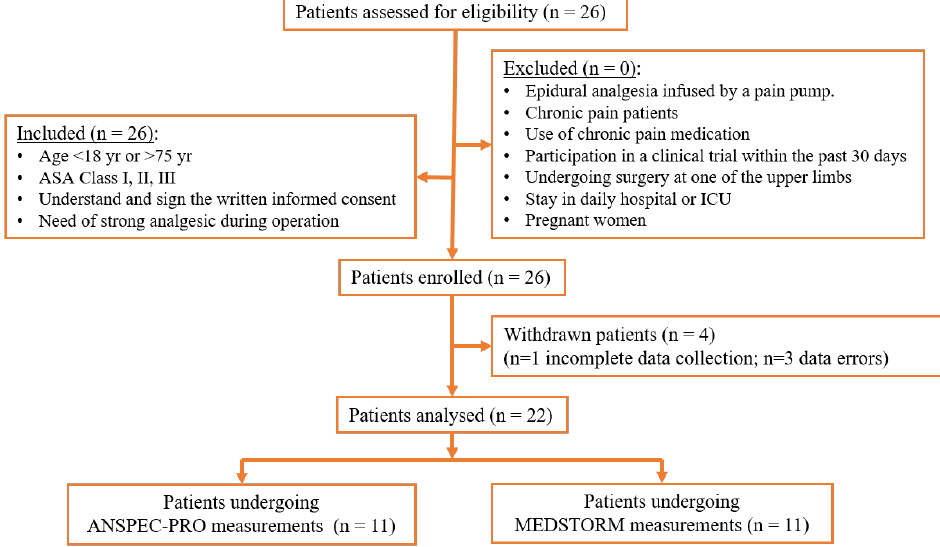
Figure 3. Study subject flow diagram. Table 1. Patients characteristics and clinical data.